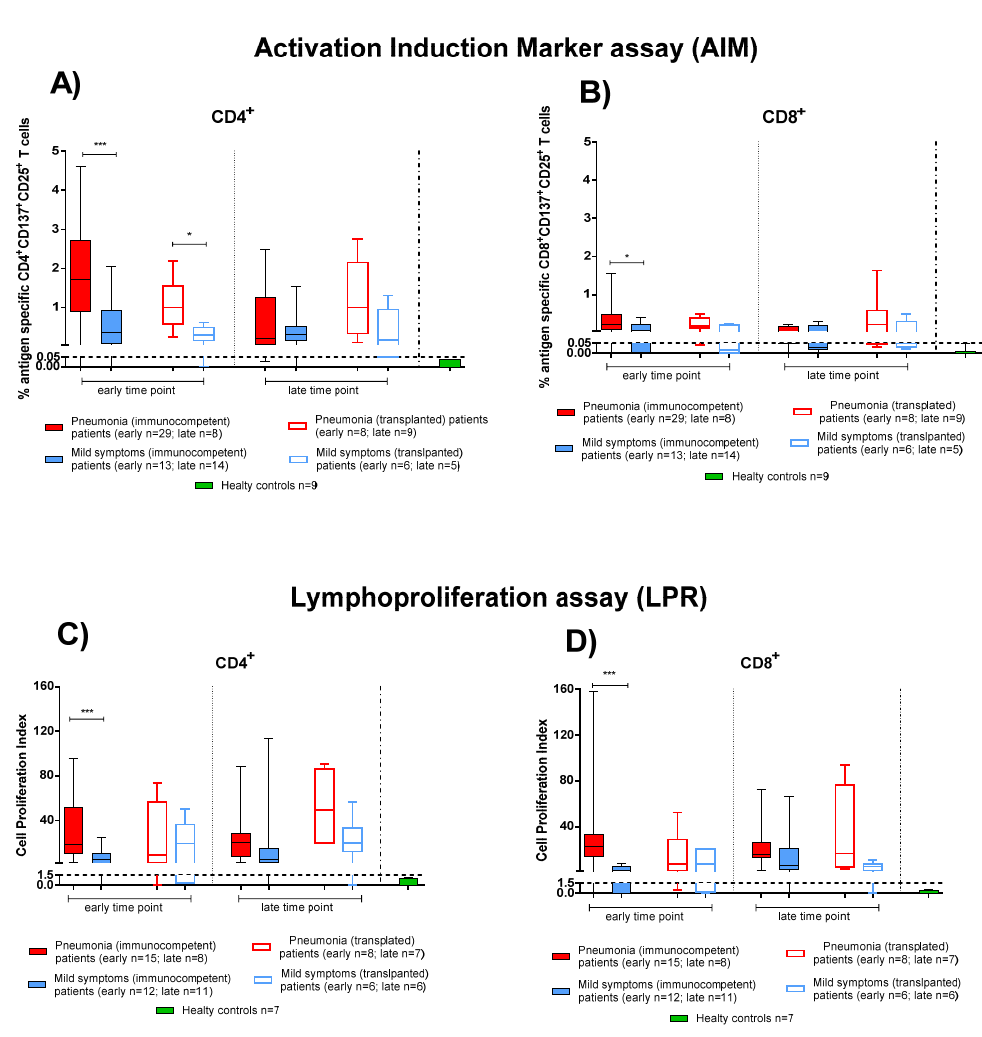
Figure 3. SARS-CoV-2-specific T-cell responses were compared between immunocompetent (IC) and transplanted (TX) patients with pneumonia or mild symptoms at early and late time points. ( A ) SARS-CoV-2-specific CD4 + and ( B ) CD8 + T-cells (rapid Activation Induced Marker assay); ( C ) CD4 + T-Cell Proliferation Index; ( D ) CD8 + T-Cell Proliferation Index. Early time point: patients with pneumonia, IC median 58 (range 45–100); TX 60 (30–62) days after infection; patients with mild symptoms, IC 48 (30–100); TX 54 (26–75) days after infection. Late time point: patients with pneumonia, IC median 212 (range 186–400); TX 233 (164–309) days after infection; patients with mild symptoms, IC 192 (150–306); TX 167 (150–207) days after infection. * p < 0.05; *** p < 0.001.